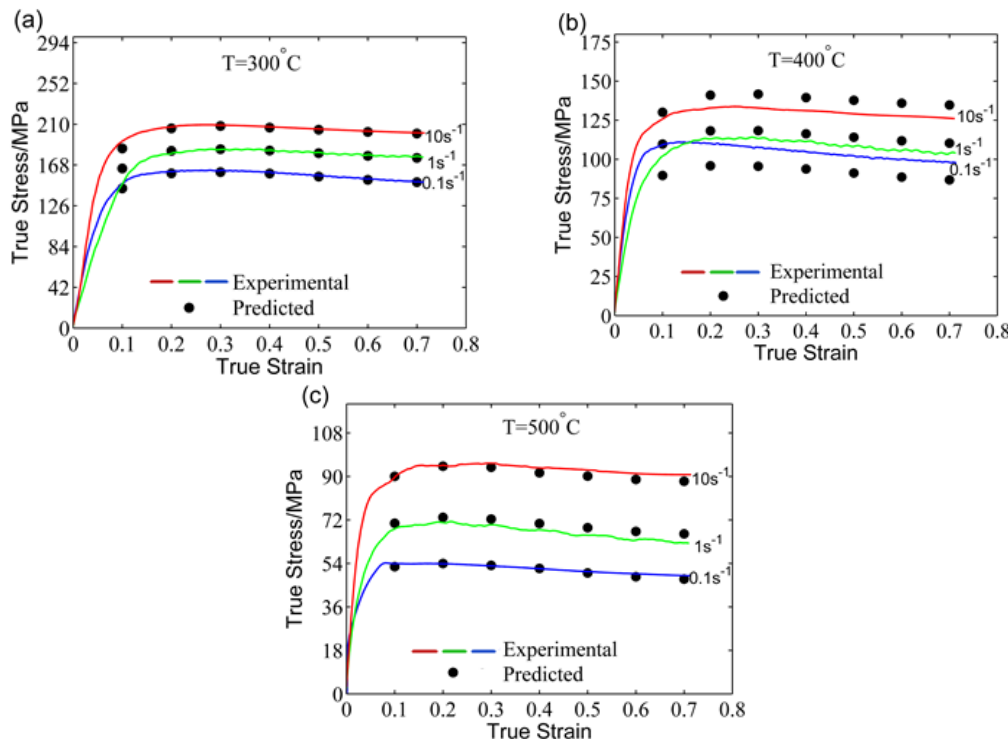
Figure 5. Comparisons of the predicted and experimental flow stress by the strain-compensation Arrhenius (SA) model at ( a ) 300 °C, ( b ) 400 °C, and ( c ) 500 °C.